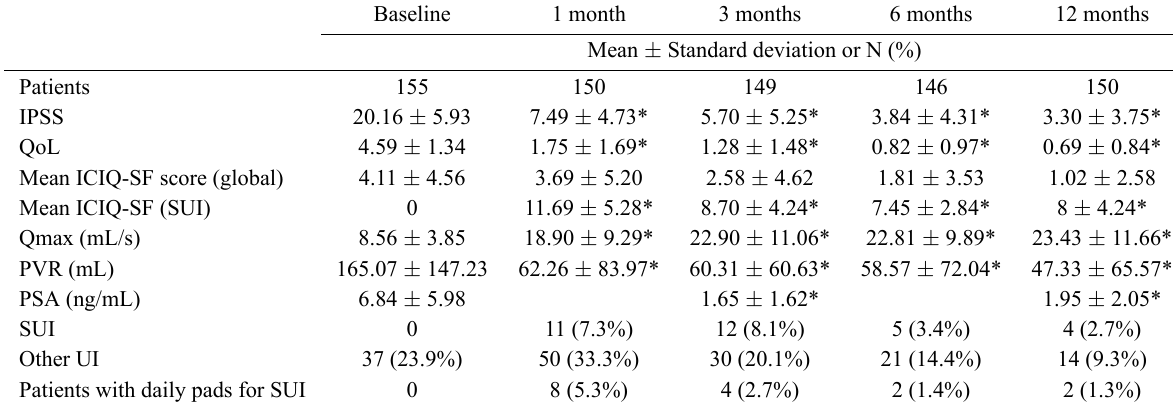
Table 2. Urinary function follow-up and incidence of